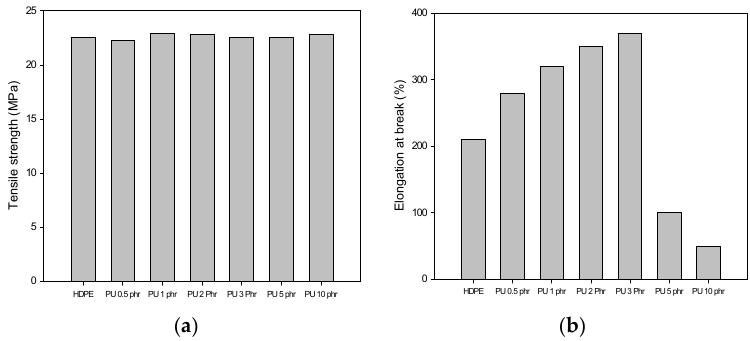
Figure 1. ( a ) Tensile strength and ( b ) elongation at break of polyurethane/high ‐ density polyethylene (PU/HDPE) composite at various content of PU; radiation dose is 25 kGy.